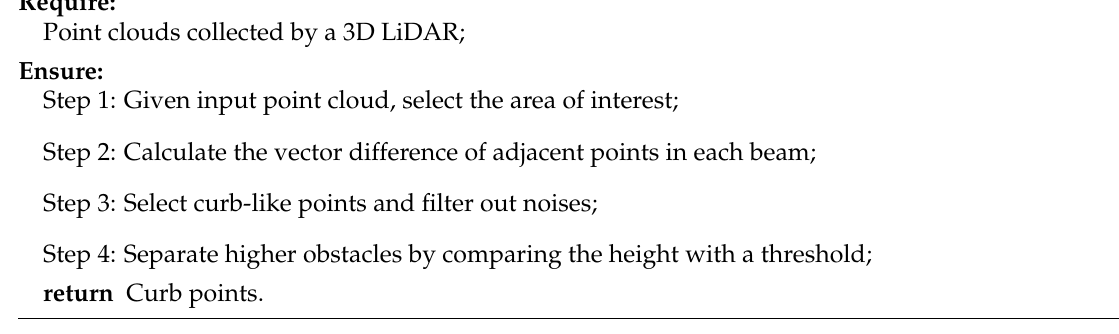
Algorithm 1 Framework of curb detection.